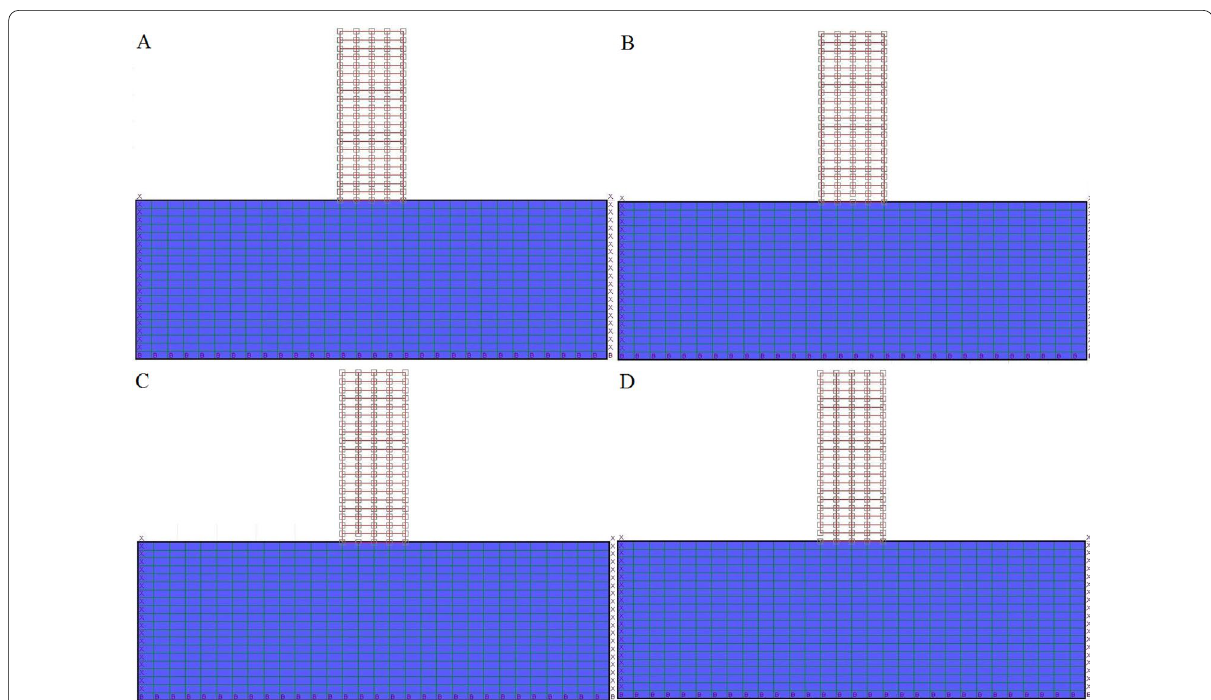
Fig. 6 The numerical models of the 20-story frames. A without column removal, and with B middle, C corner, and D edge column removal in the FLAC